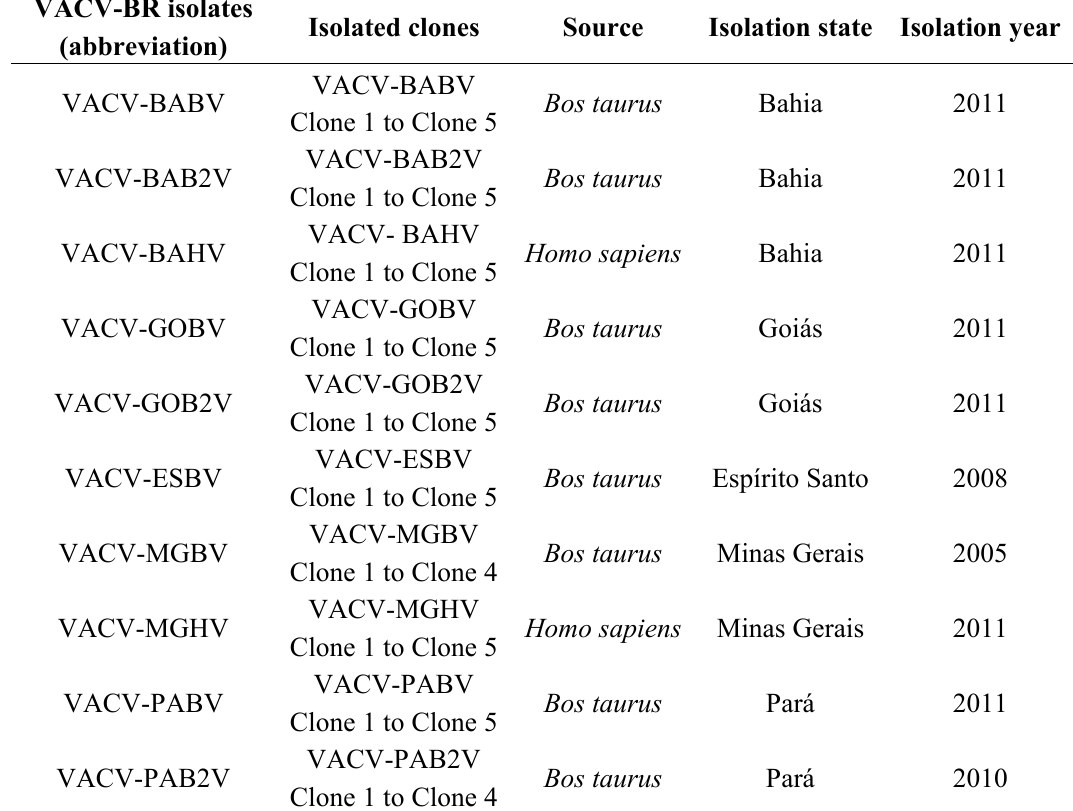
Table 1. Identification of viral clones isolated from clinical